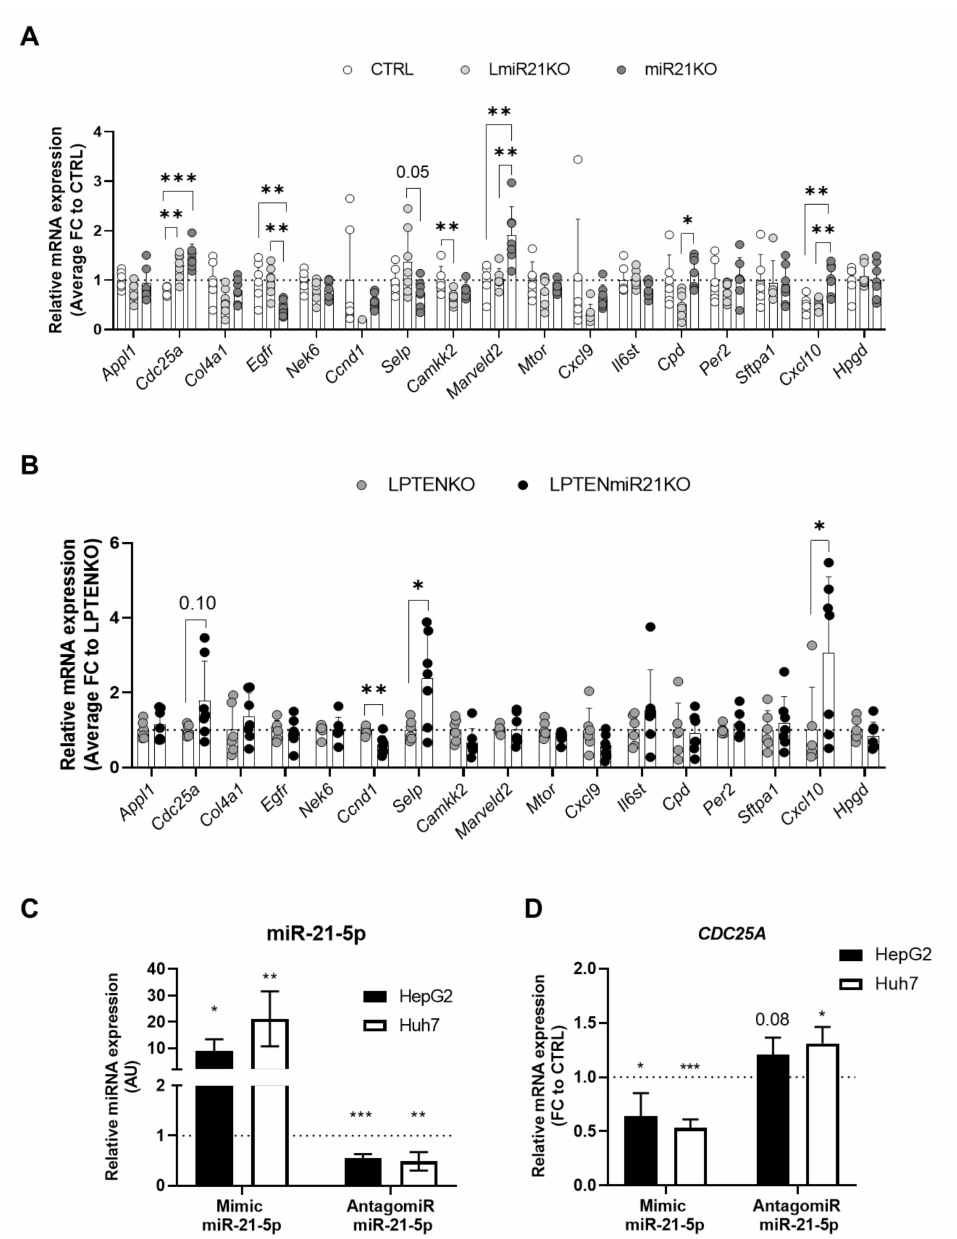
Figure 5. miR-21 deficiency in vivo is associated with Cdc25a overexpression and deregulated expression of immunity-related factors in the liver. RT-qPCR analysis of Appl1, Cdc25a, Col4a1, Egfr, Nek6, Ccnd1, Selp, Camkk2, Marveld2, Mtor, Cxcl9, Il6st, Cpd, Per2, Sftpa1, Cxcl10, and Hpgd expression in hepatic tissues of ( A ) 11-month-old control (CTRL, n = 6), hepatocyte-specific (LmiR21KO, n = 7), and total miR-21 (miR21KO n = 7) knockout mice injected with DEN and ( B ) 12-month-old hepatocyte-specific PTEN knockout (LPTENKO, n = 6) and PTEN/miR-21 knockout (LPTENmiR21KO, n = 7) mice. Data from DEN-injected miR-21 KO mice is represented as mean ± SD fold-change (FC) to DEN-treated CTRL mice. Data from LPTENmiR21KO is represented as mean ± SD FC to LPTENKO mice. ( C ) miR-21-5p expression and ( D ) CDC25A expression in HepG2 and Huh7 hepatic cancer cell lines, transfected for 48 h under basal culturing conditions with either miR-21-5p mimicking oligonucleotides (mimic) or miR-21-5p inhibiting oligonucleotides (antagomir). CDC25A expression is represented as mean ± SD FC to Control Mimic or Control Antagomir. Data that failed normality tests was submitted to log10-transformation prior to statistical analysis. An outliers test was performed using the ROUT method (Q=1%). Unpaired t -test with Welch’s correction was used for comparison between two groups. One-way ANOVA with Holm–Sidak’s correction was used for comparison between more than two groups. * p -value < 0.05, ** p -value < 0.01, *** p -value <